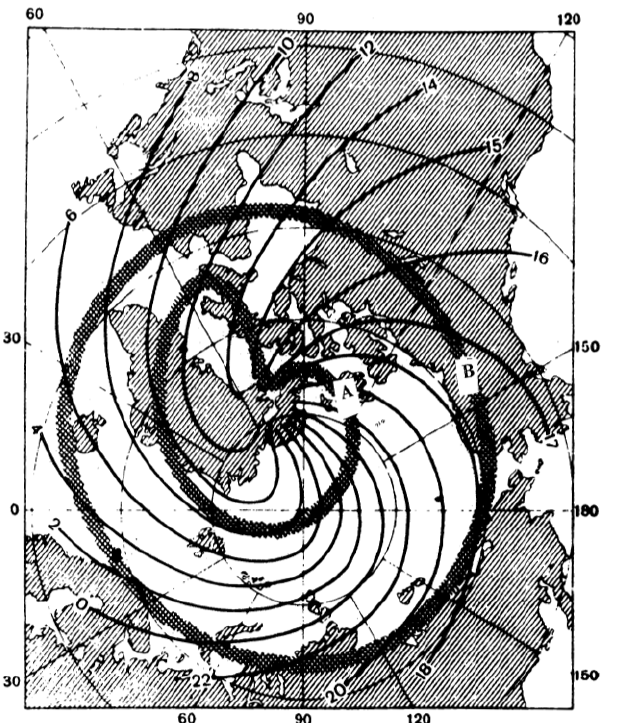
Figure 4. Isochrones of the dawn maximum of magnetic activity in form of spirals, which arise from the geomagnetic pole of the back- ground magnetic field. The numbers along the spirals indicate the UT maximum in the diurnal variation of magnetic activity. Capital letters signify the auroral zones of Alfv´en-Nikolsky (A) and Fritz- Vestine (B),